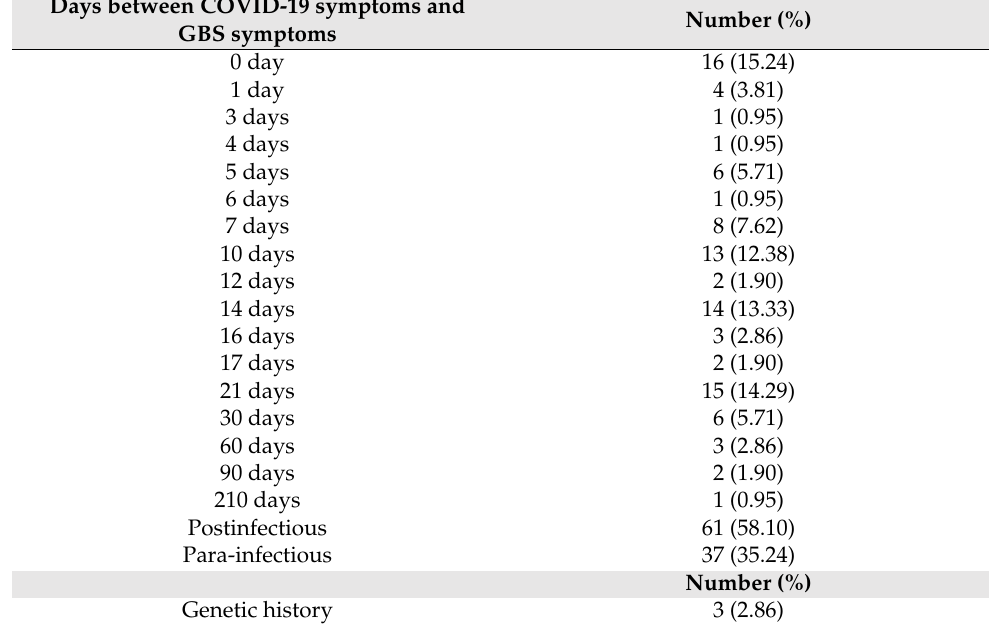
Table 2. Cont. Days between COVID-19 symptoms and